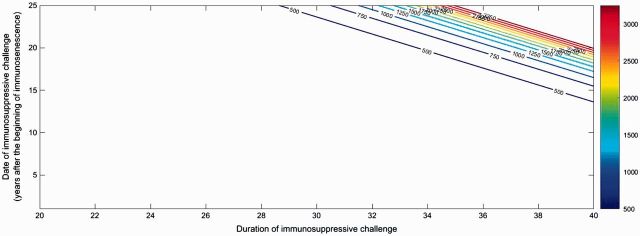
Contour plot of the number of cancerous cells at 80 (ranging from dark blue for accumulation of < 500 cancer cells to dark red for situations with >3000 cells) according to the date of an immunosuppressive infection after the beginning of immunosenescence and its duration. The maximal number of cancerous cells accumulates for 20 challenges with a total duration of 40 years (i.e. 3311 cells). Parameters are detailed in Table 1